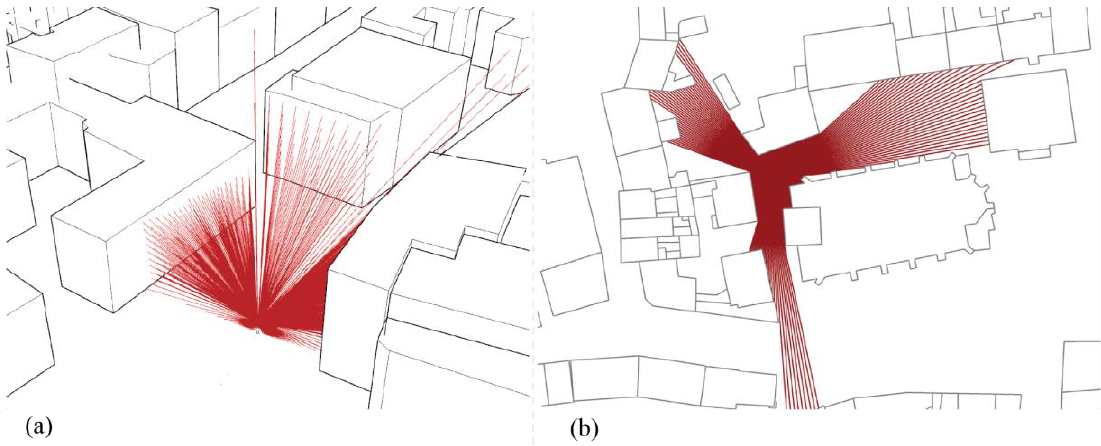
Figure 6. Isovist visualized by rays. ( a ) perspective view of 3D isovist and ( b ) Top view of 2D isovist.